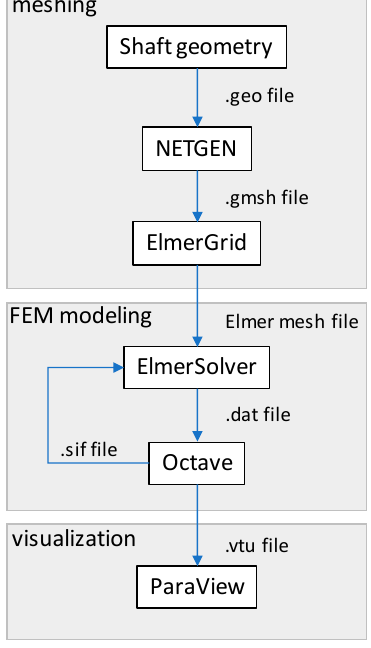
Figure 1. A schematic block diagram of information flow during the modeling process.